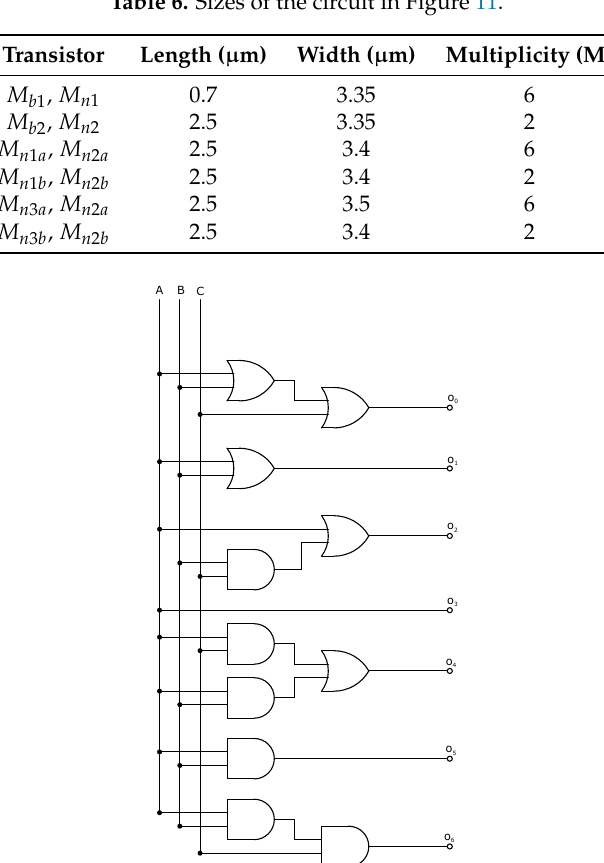
Table 6. Sizes of the circuit in Figure 11.